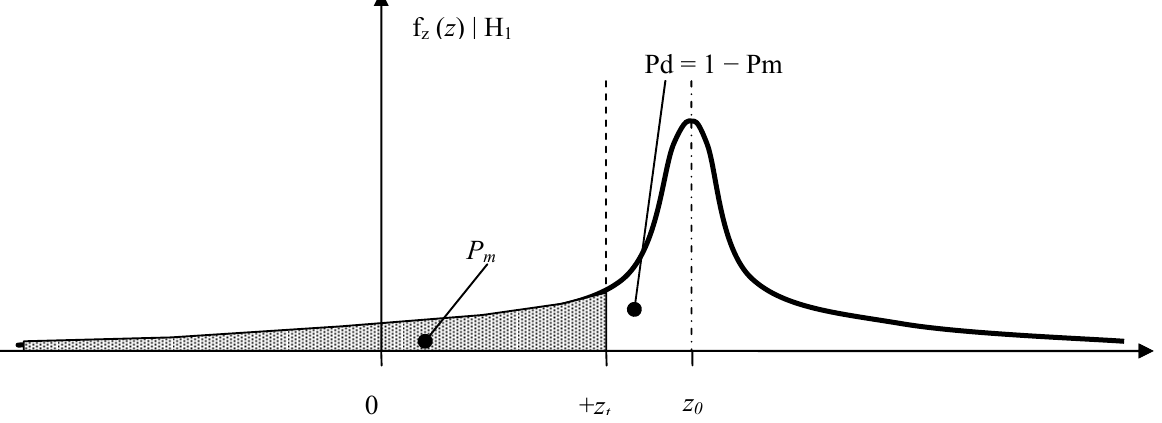
Figure 7. Probability of detection in a positive turnout D1|H1. The threshold value in and the turnout induced yaw rate is z deg/sec is z t